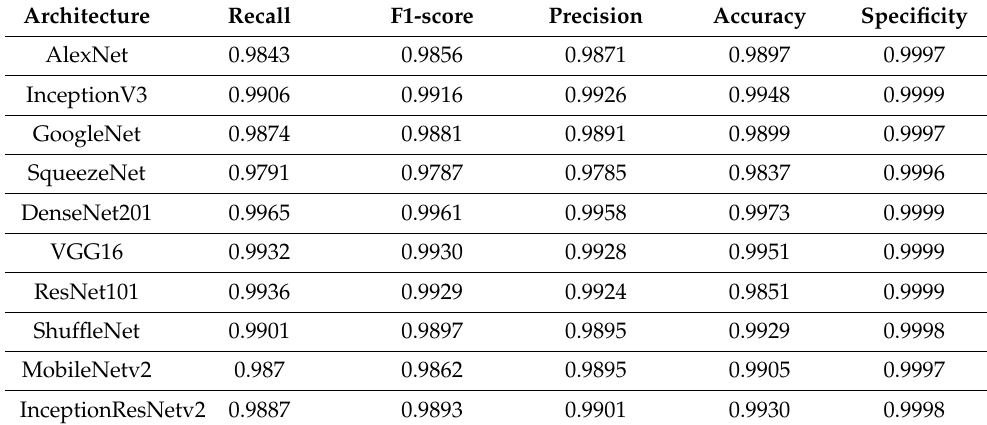
Table 6. The test set performance of 10 models considered in this comparative study.